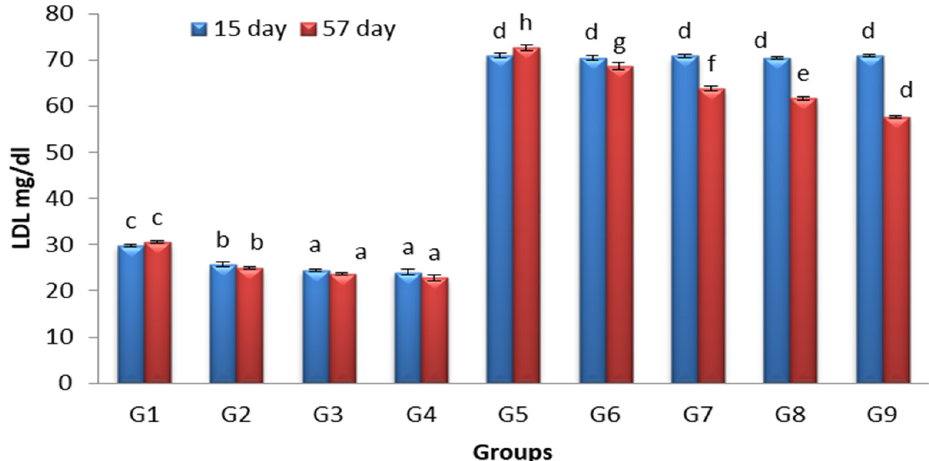
Figure 5. The influence of L. plantarum , L. casei , S. platens and their combination on low-density lipoprotein cholesterol (LDL-C) levels in albino mice (mg/dL) at 15 and 57 days. Error bars represent SE of mean. G1: regular diet (RD); G2: RD + Lp + Lc; G3: RD + Sp; G4: RD + Lp + Lc + Sp; G5: high-cholesterol diet (Ch); G6: Ch + Lp + Lc; G7: Ch + Sp; G8: Ch + Lp + Lc + Sp; G9: Ch+ rosuvastatin. Bars with different superscript are significantly different p < 0.05).